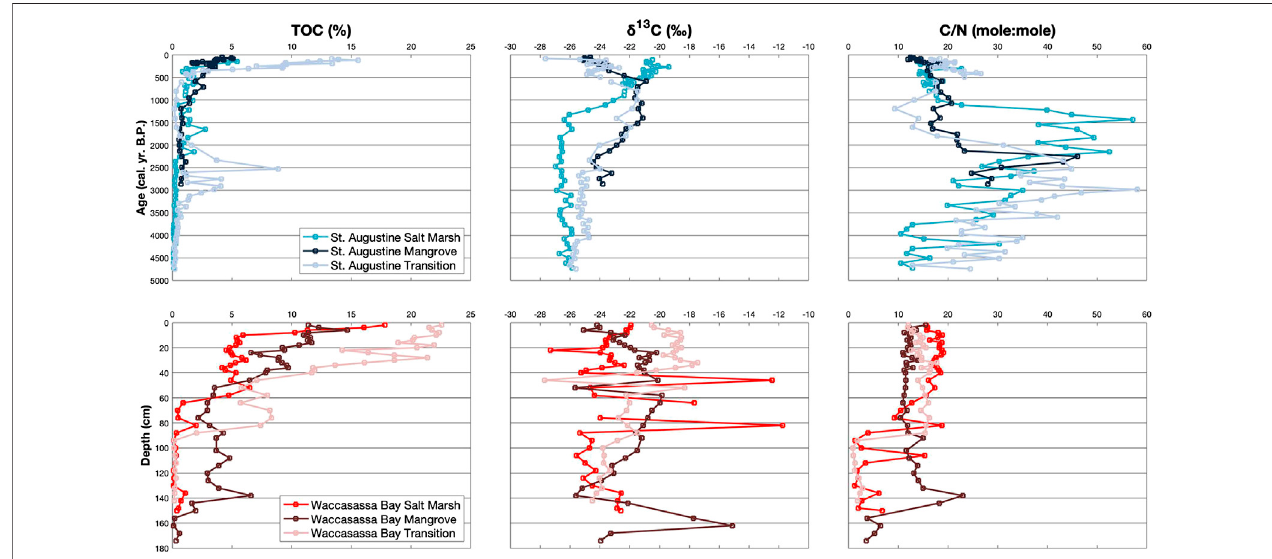
FIGURE 2 | Down-core measurements of TOC (%), δ 13 C ( ‰ ), and C/N for cores in St. Augustine (top blue plots) and Waccasassa Bay (bottom red plots) . St. Augustine cores are plotted against calibrated ages (cal. yr. B.P.) and Waccasassa Bay cores are plotted against depth (cm).